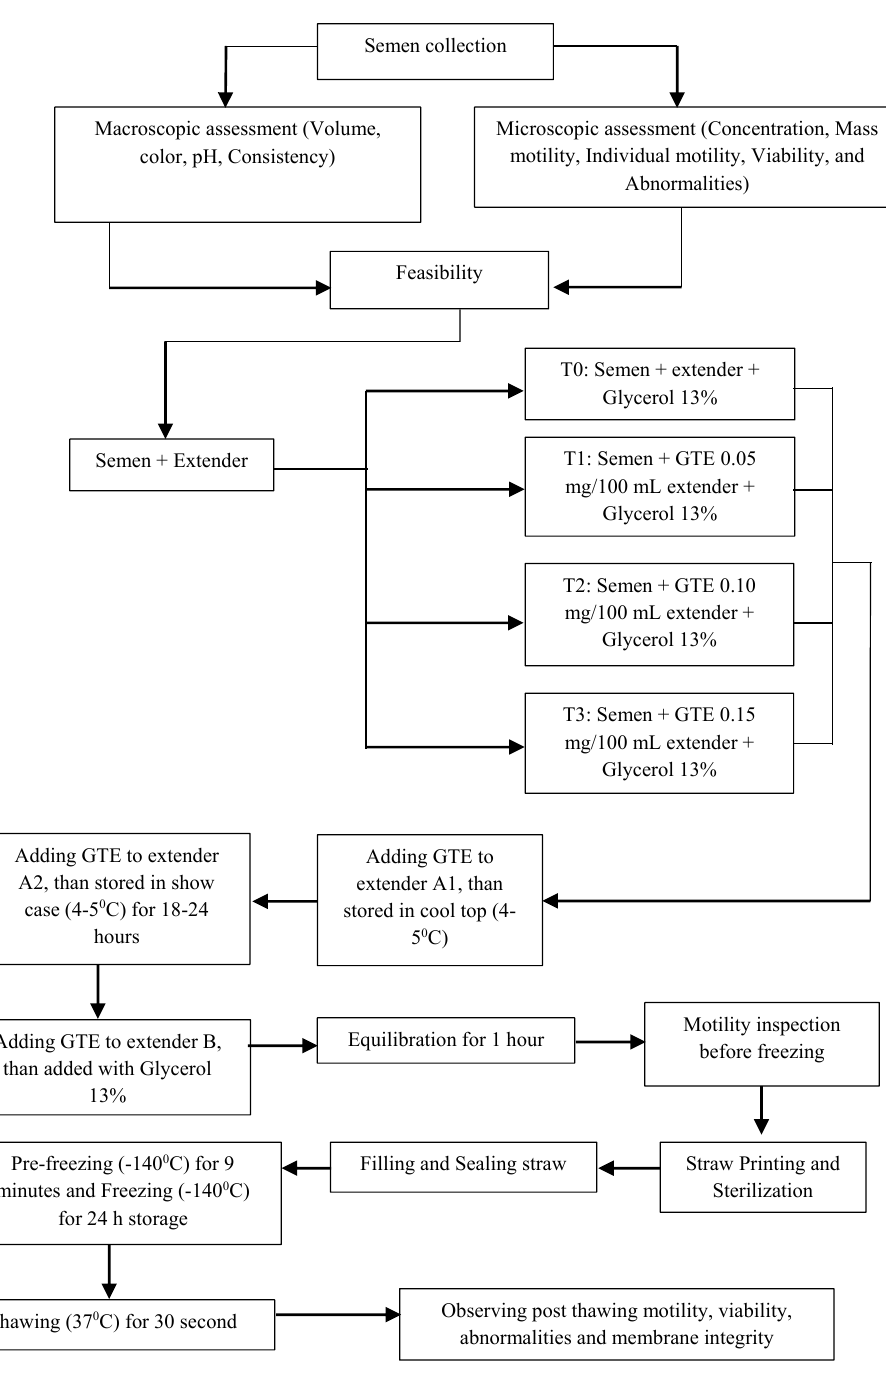
Figure 1. Procedure for adding green tea extract to the Tris-based egg yolk extender.